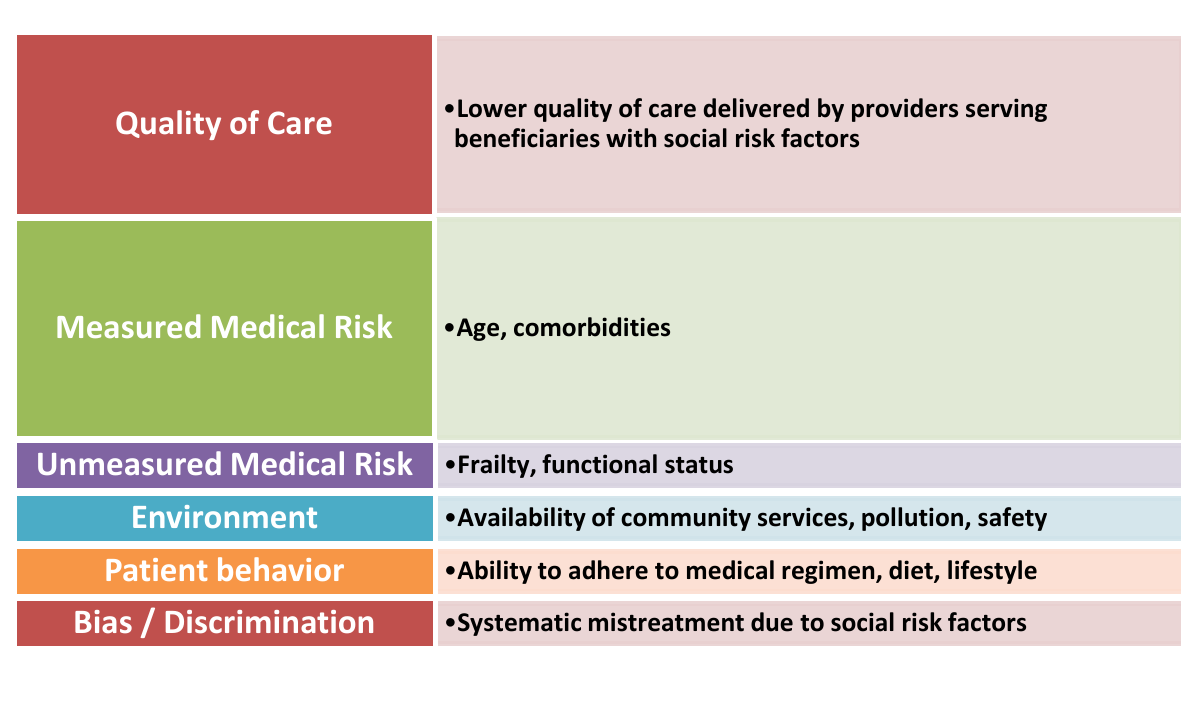
Figure 1.1: Theoretical Factors Contributing to Differences Between Risk of Readmission for Beneficiaries With vs. Without Social Risk